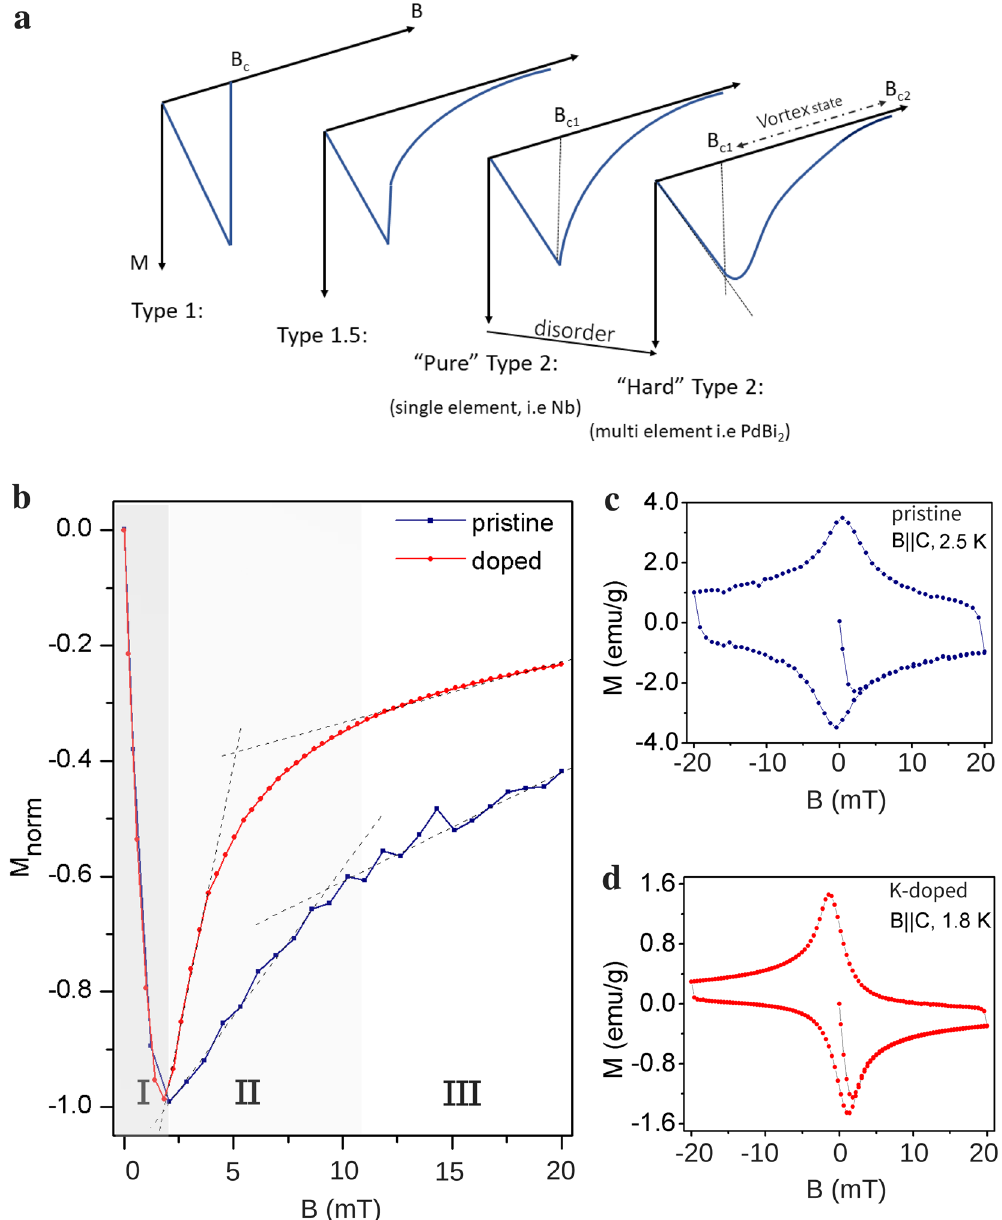
Figure 2. Vortex State. ( a ) B c 1 < B < B c 2 is the vortex state: flux vortices start to penetrate the superconductor at B c 1 and form a vortex lattice. Irreversibility of the magnetization loop is due to flux pinning effects. At the irreversibility field, the vortex lattice melts, restoring the reversibility. Doping increases the number of pinning sites and consequently, irreversibility. However, a spin-triplet superconductor does not follow this conventional behaviour; their vortex state is mostly ‘liquid’, resulting in poor flux pinning and reversibility. This behaviour is dubbed Type 1.5 27 . ( b – d ) Comparison of the normalized magnetization along the B || c plane of both the undoped and doped sample, at 2.5 K and 1.8 K respectively. Beyond B c 1 of K-doped β -PdBi 2 the magnetization shows an anomalous rate of increase in magnitude which is at odds with the conventional type-II “alloy” superconductors but consistent with the expectation for spin-triplet